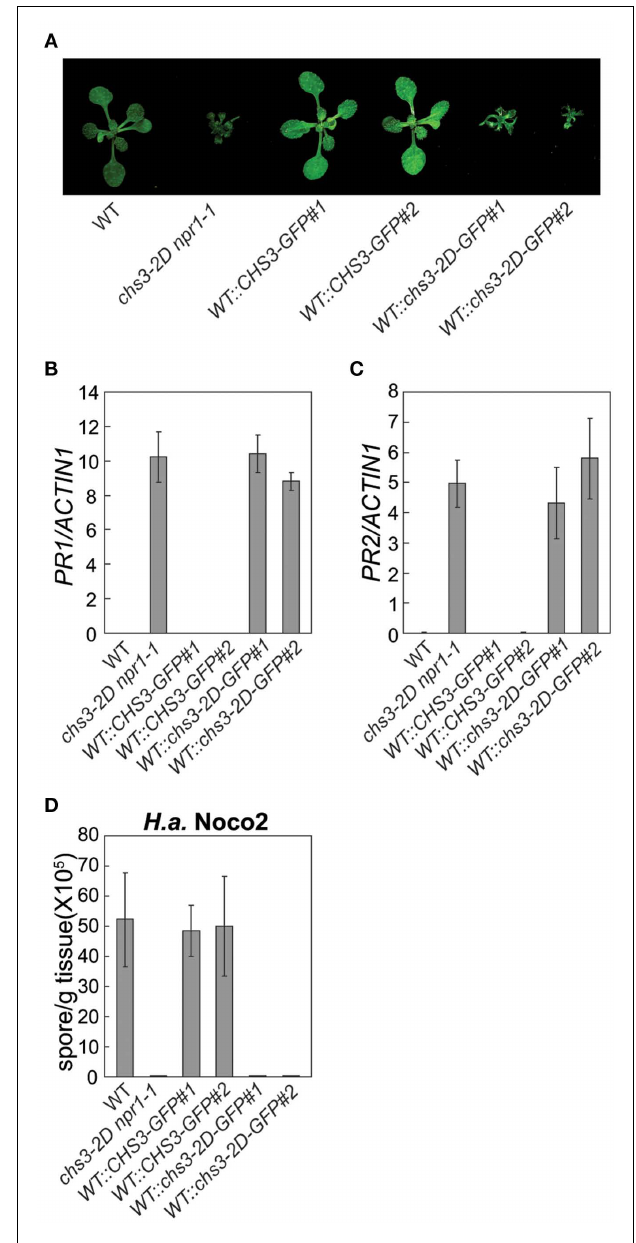
FIGURE 3 | Characterization of transgenic plants expressing CHS3 -GFP or chs3-2D-GFP under the control of its endogenous promoter. (A) Morphology of wild type (WT), chs3-2D npr1-1 , CHS3-GFP line 1, CHS3-GFP line 2, chs3-2D-GFP line 1, and chs3-2D-GFP line 2 soil-grown plants. CHS3-GFP and chs3-2D-GFP constructs were expressed in theWT Col-0 background. Representative plants were photographed 4weeks after germination. (B,C) Endogenous expression of (B) PR1 and (C) PR2 relative to Actin 1 in the above-mentioned genotypes.Values presented are averages of three replicates ± SD. (D) Growth of H.a. isolate Noco2 on the above-mentioned genotypes 7days post-infection.Values presented are averages of three replicates ±